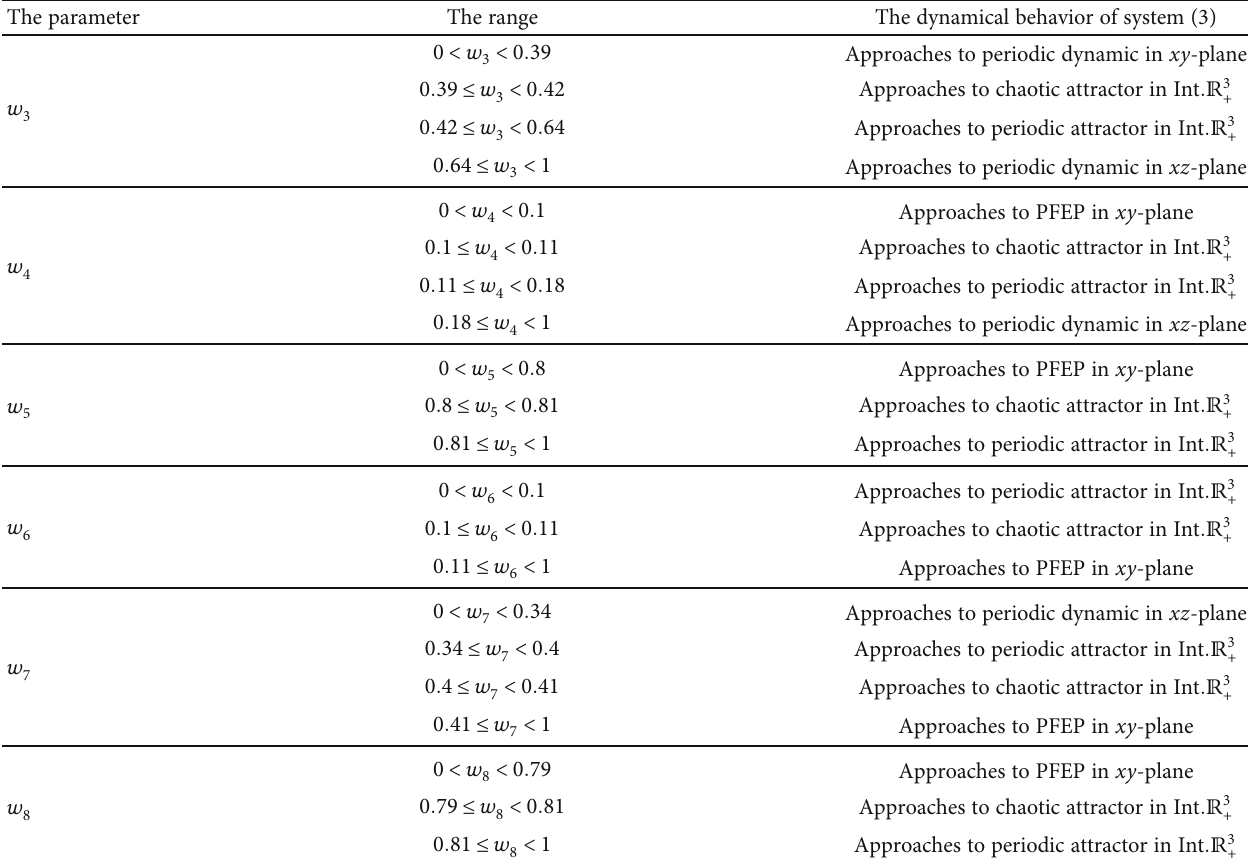
Figure 8: Trajectory of system (3) using the data given by Equation (87). (a) Asymptotic stable PFEP in the xy -plane given by E 0 : 53, 0 Þ where w = 0 : 15 . (b) Time series of attractor in (a). (c) Chaotic attractor in Int : ℝ 3 2 Table 1: The dynamical behavior of system (3) using the data (87) with varying a speci fi c parameter. The parameter The range The dynamical behavior of system